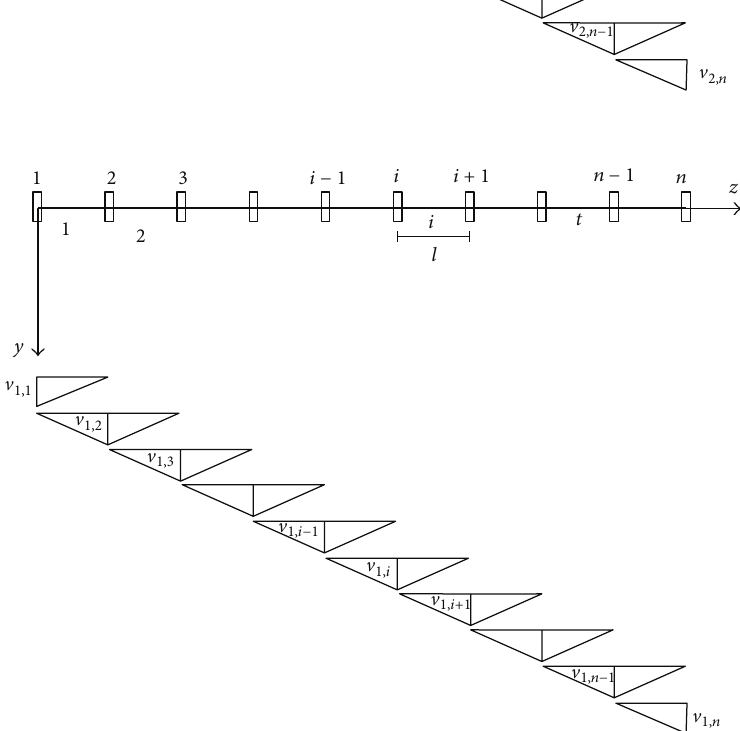
Figure 2: Structural system